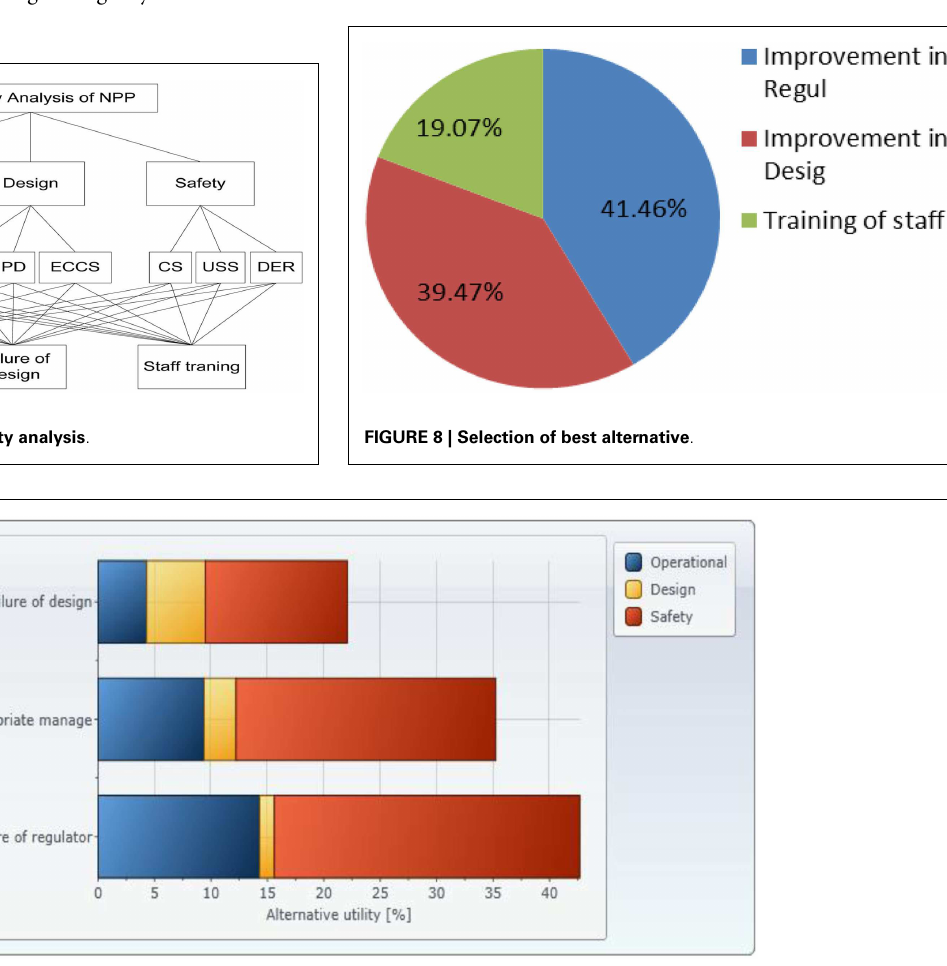
FIGURE 7 | Main cause of accident in context of criteria